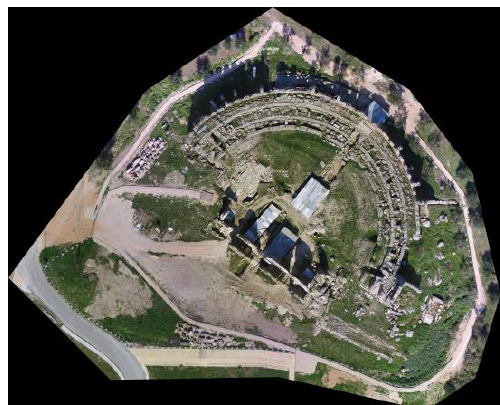
Figure 1. Ancient Nikopolis theatre. Drone